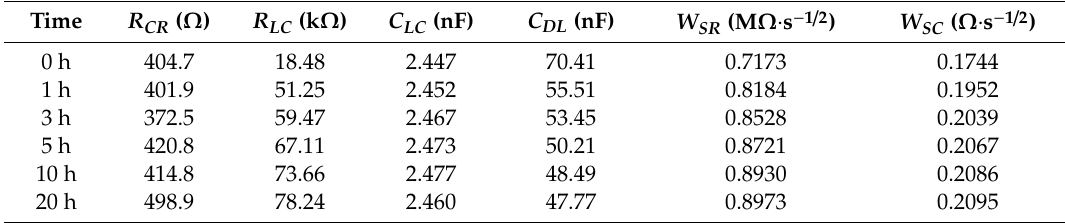
Table 1. Electrochemical impedance spectroscopy parameters as the elements of the equivalent circuit model obtained by using the measured impedance